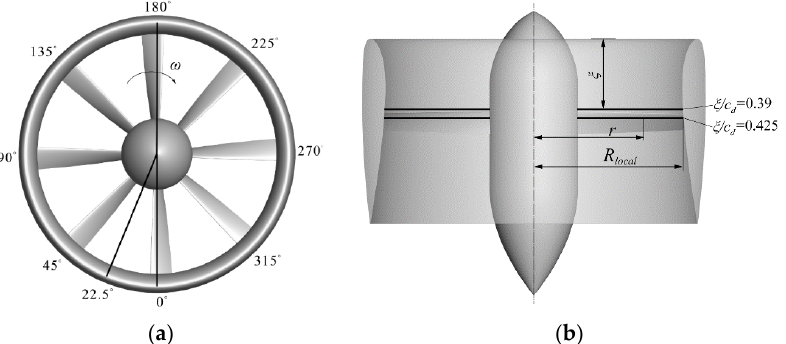
Figure 16. Locations of cross sections used in analysis: ( a ) azimuthal cross sections; ( b ) axial cross sections.